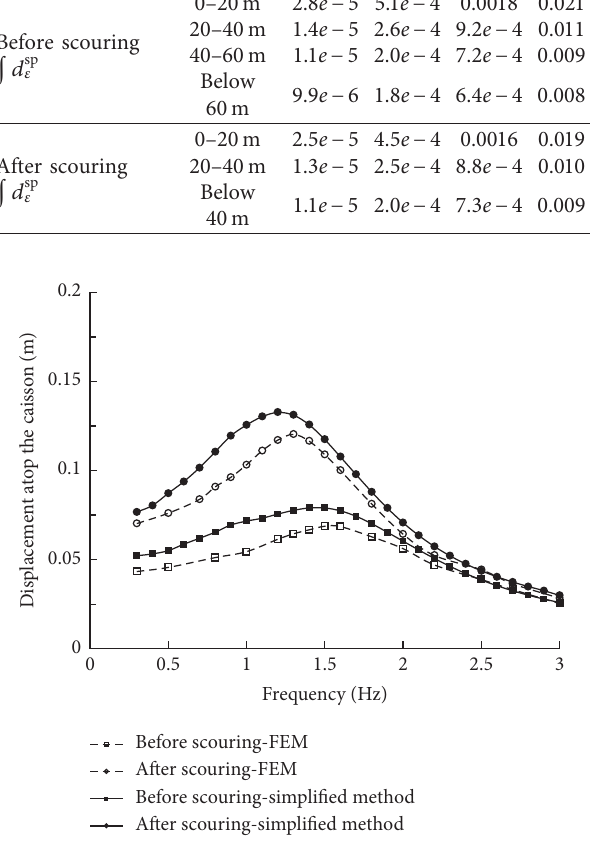
Figure 6: Dynamic response of caisson before and after